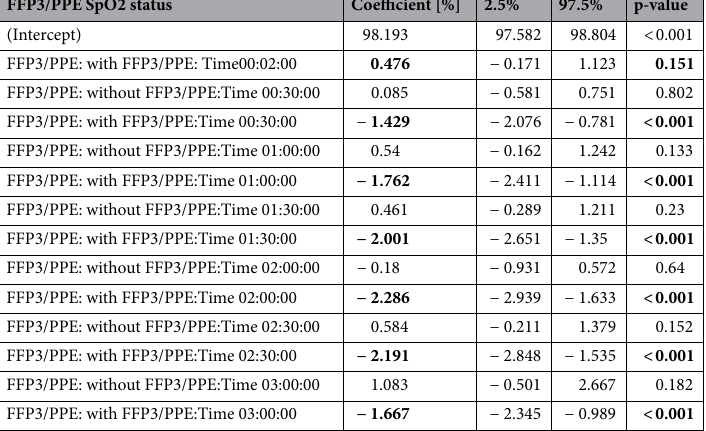
Table 3. Linear mixed-effects model (LMM): SpO2 [%] ~ FFP3/PPE + FFP3/PPE: time + (Second/person). Significant values are bold.